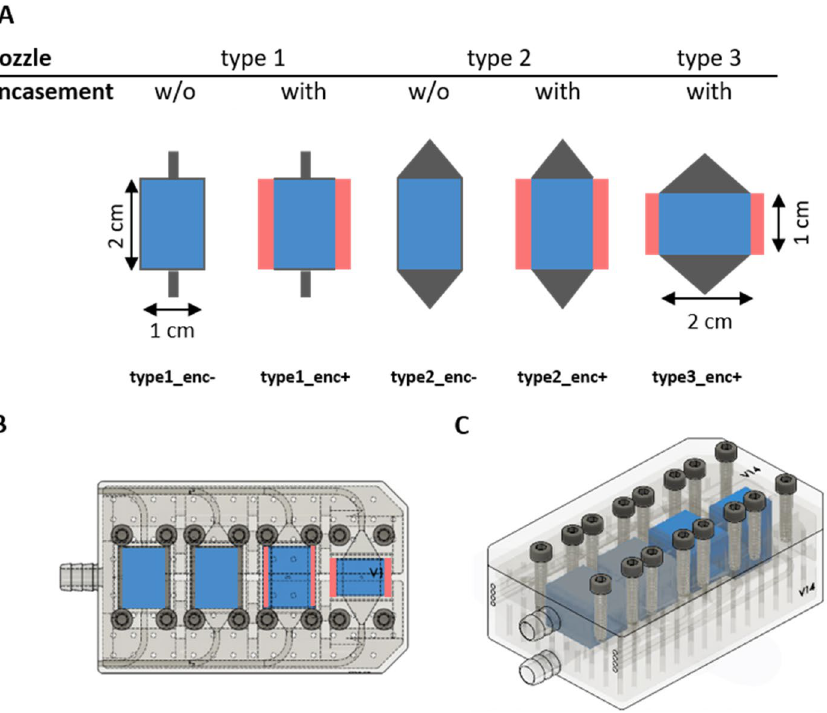
Figure 2. Bioreactor prototypes. ( A ) Schematic presentation of the different bioreactor types (longitudinal section). Black: shape of the perfusion chamber and the inflow/outflow nozzles. Blue: scaffold block. Red: silicone encasement around the scaffold. The perfusion chambers of type 1 and type 2 are 1 cm in width and 2 cm in height, type 3 is 2 cm in width and 1 cm in height. The presence or absence of the encasement is indicated by enc+ or enc−, respectively. ( B ) Design of the four bioreactors integrated in a single 3D-printed block drawn by Autocad Fusion 360. The different inlet and outlet geometries are visible above and below the scaffold chambers. Arrows indicate separate inflow and outflow lines of the chambers. Central connectors are needed for the water circulation system to regulate the temperature. Bioreactor types 2 and 3 with encasement harbor a silicone sealing (red) for the scaffolds (blue). ( C ) 3D view of the bioreactor without the silicon